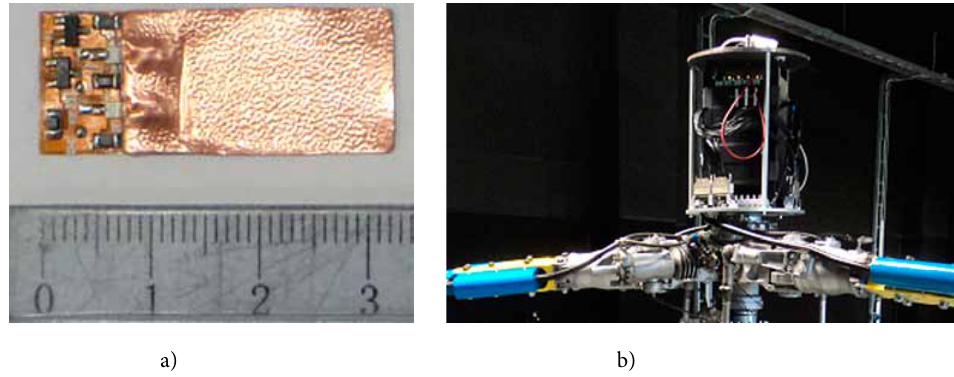
Fig. 4. Single deformation transducer (a); acquisition unit on the rotor hub (b)